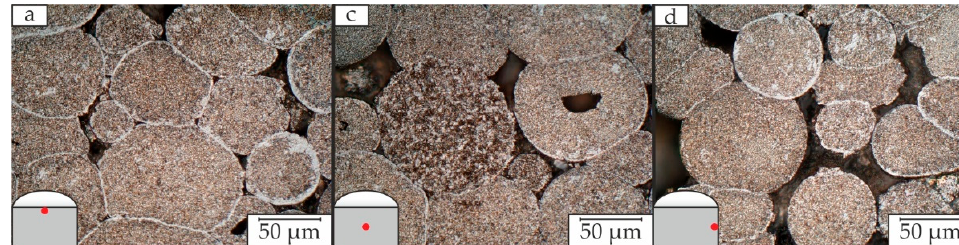
Figure 12. Microstructure in defined positions a, c and d according to Figure 1 (right) of a TNM sample sintered at 1150 °C, with 2 min dwell time and 30 MPa pressure.